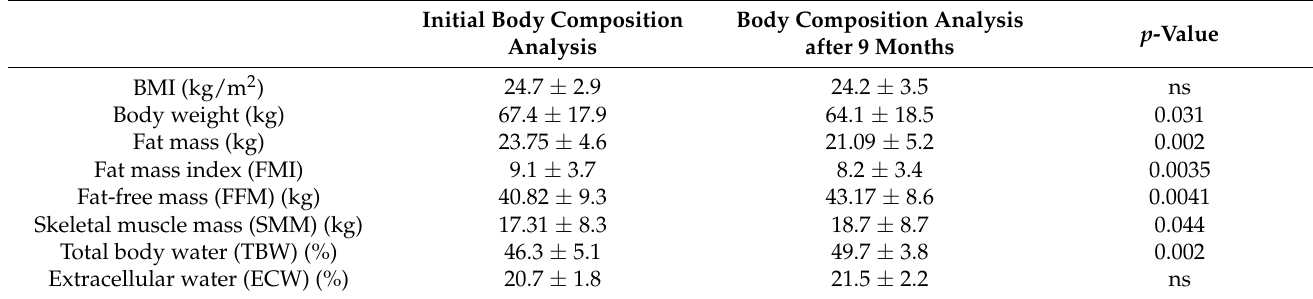
Table 3. Initial body composition and changes after 9 months among adults with celiac